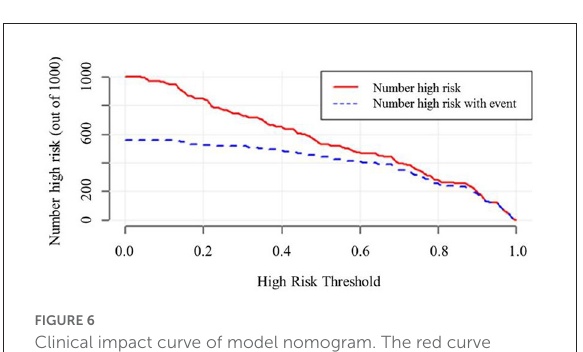
FIGURE6 Clinical impact curve of model nomogram. The red curve (Number high risk) indicates the number of people who are. The blue curve (Number of high risk with outcome) indicates the number of true positives. When the threshold probability was > 90.0% of the predicted probability value, the prediction model determined that the MCI high-risk population was highly matched with the actual MCI population, confirming the high clinical efficiency of the prediction